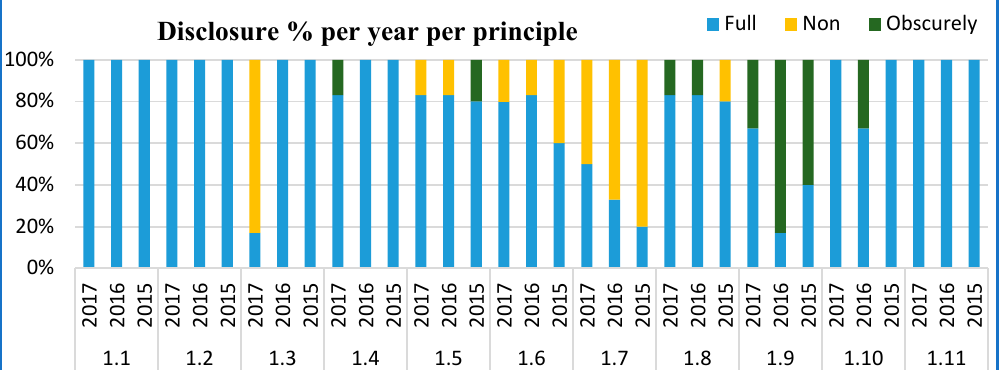
Figure 2. Risk management practice disclosure.